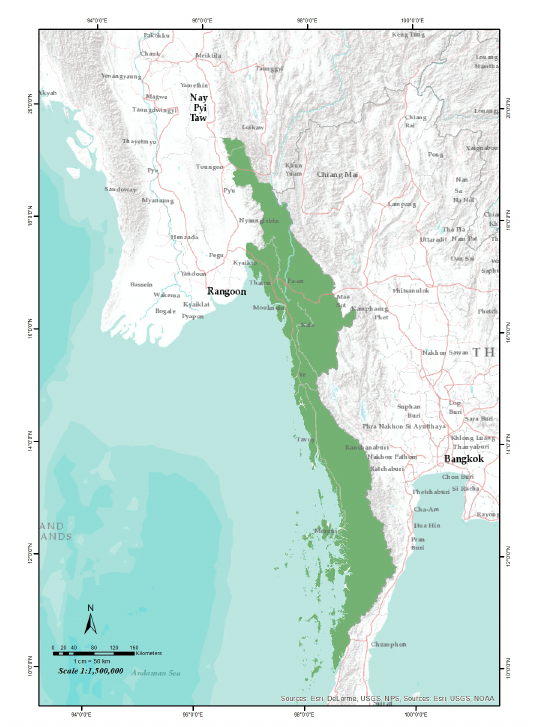
Figure 1. The study area is the Dawna Tenasserim Landscape (DTL), which covers Kayin and Mon States, and Tanintharyi Region in